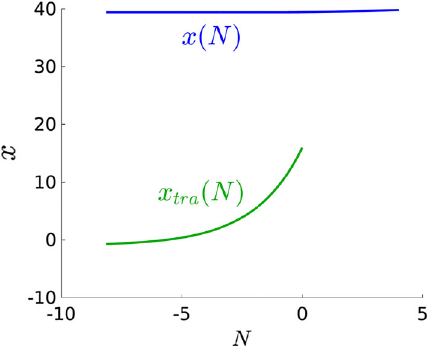
Fig. 4 Comparison of the dynamics of the tracker solution ( x tra ( N ) ; green curve) and our solution for the potential V 4 ( x ( N ) ; blue curve) assuming the reheating temperature T rh = 100 TeV